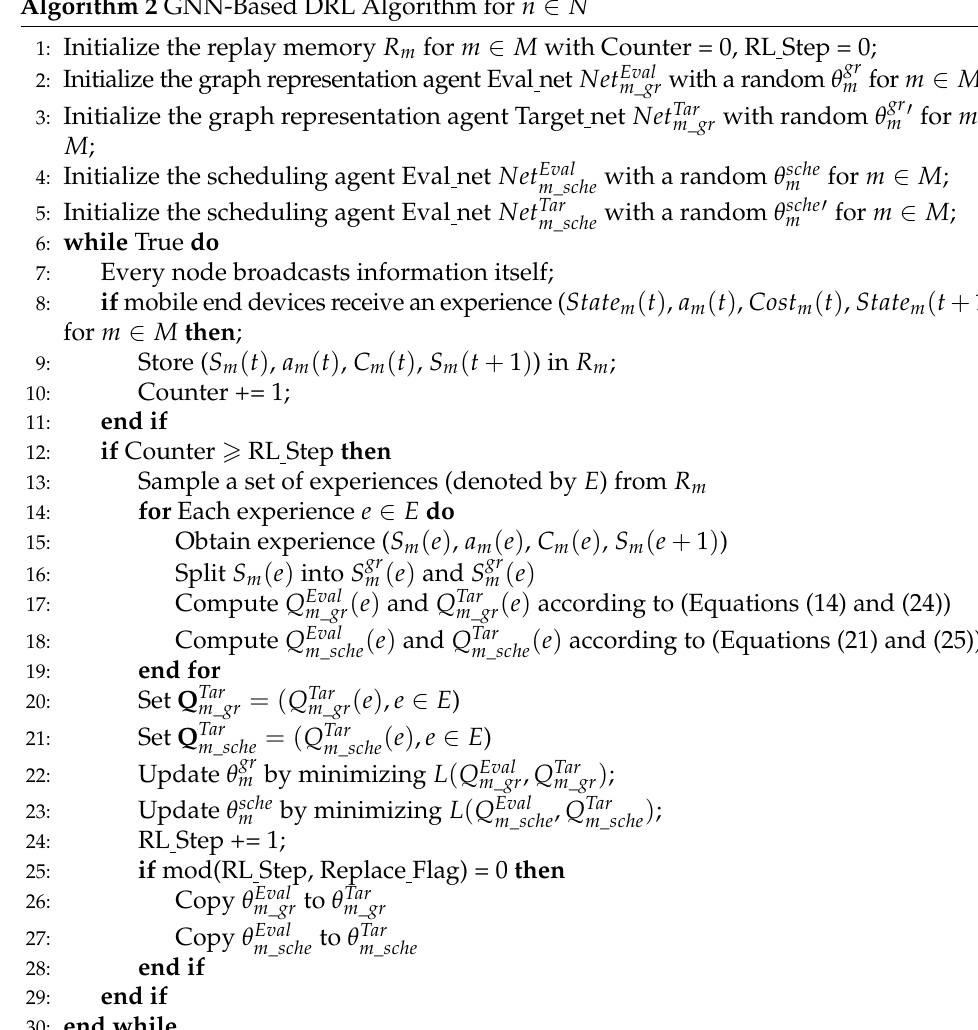
Algorithm 2 GNN-Based DRL Algorithm for n ∈